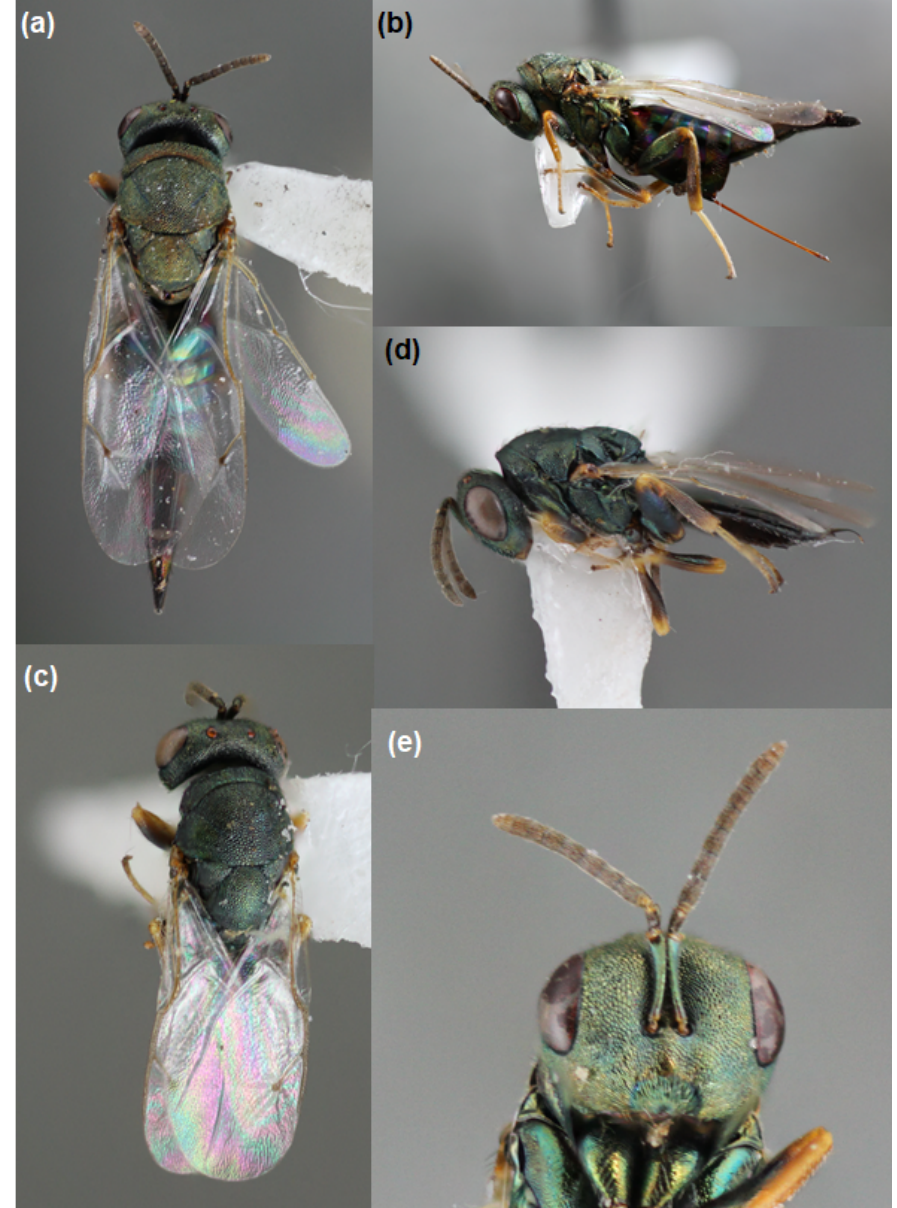
Figure 3. Pteromalus elevatus : ( a ) female dorsal view, ( b ) female lateral view, ( c ) male dorsal view, ( d ) male lateral view, ( e ) female close-up of head. Images taken by G. Fauske and cropped by D. A. Prischmann-Voldseth.